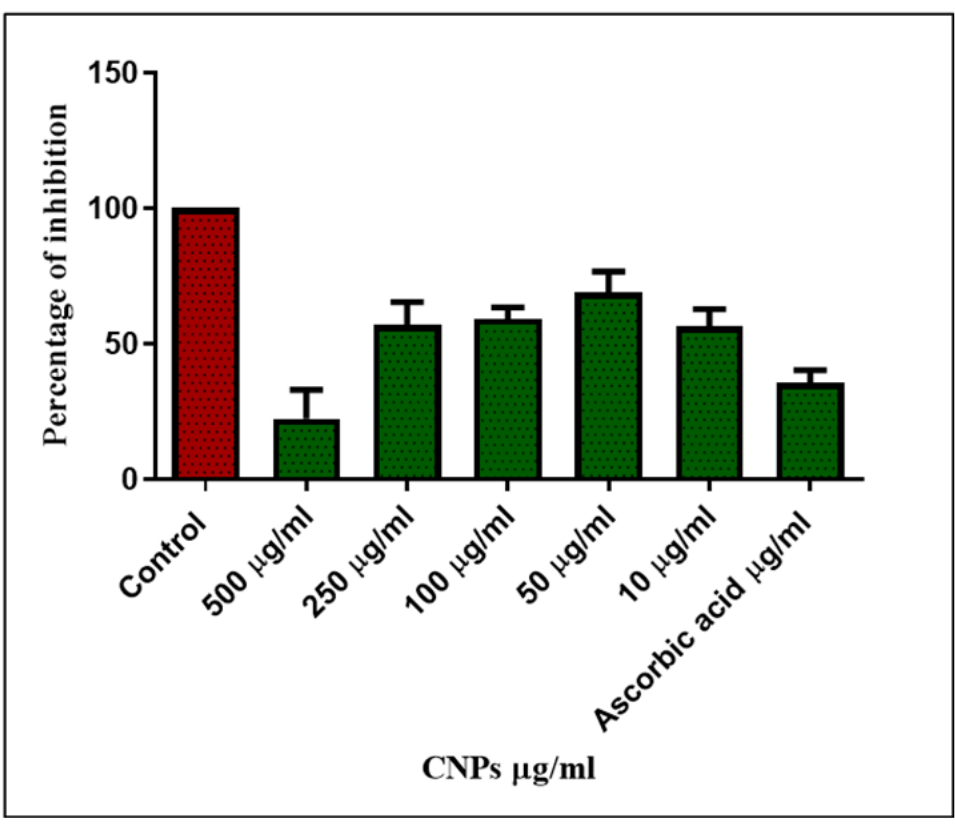
Figure 6. DPPH scavenging percentage of MAL-CNPs. Note: positive control: ascorbic acid; negative control: DPPH.